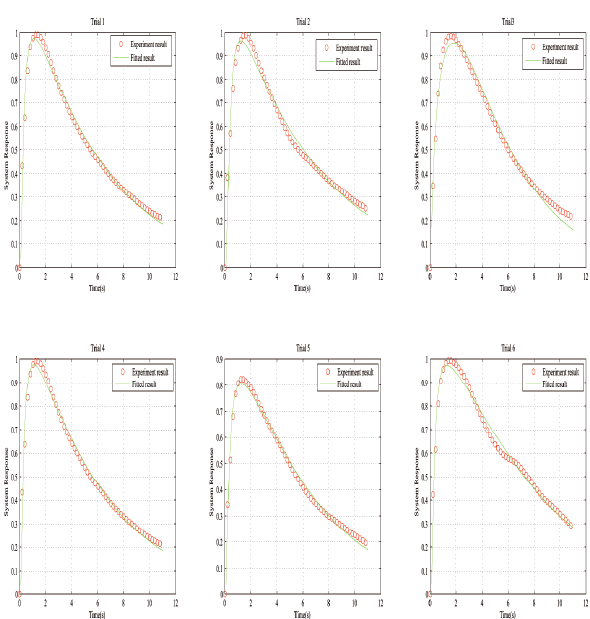
Figure 6: System response and the (cid:12)tted model for set of 6